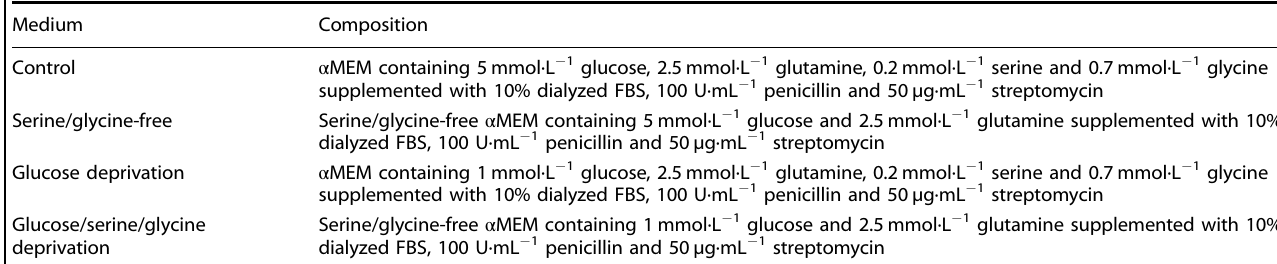
Table 1. Control and nutrient deprivation media Medium